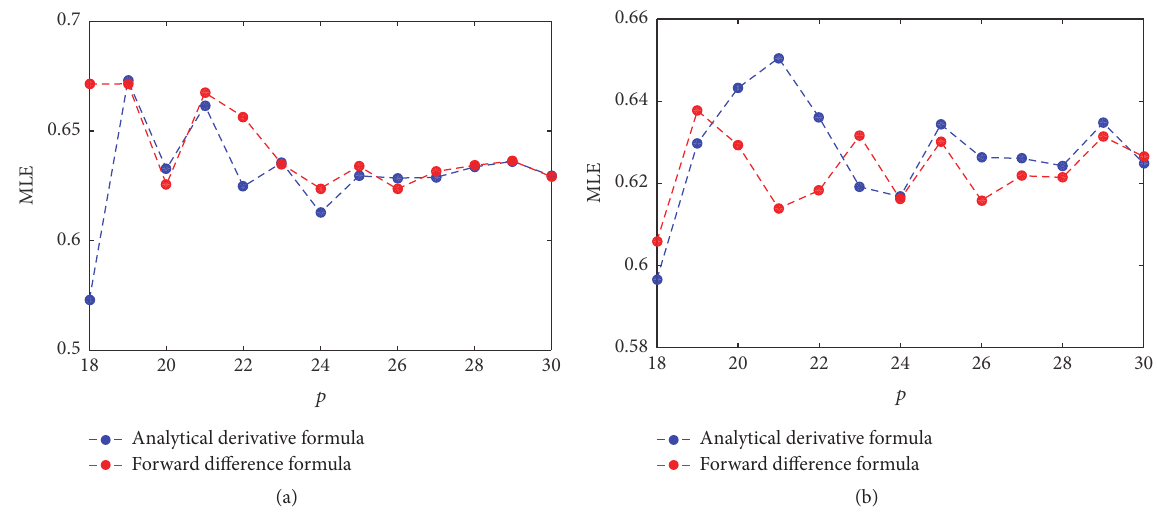
Figure 17: MLE evaluation in two different methods using 𝑓 6 (𝑥) starting at 𝑥 0 = 0.125 at (a) 𝜆 = 3.984375 and (b) 𝜆 = −1.984375 .